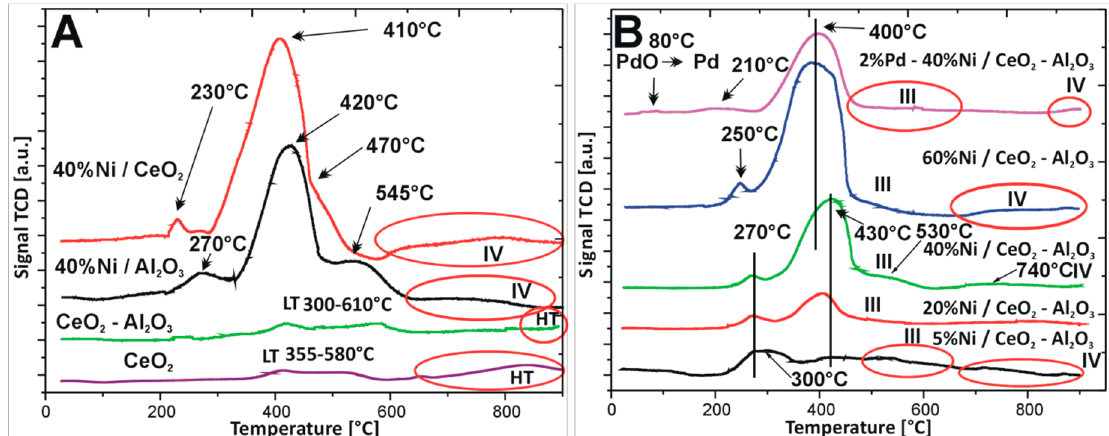
Figure 2. TPR profile of ( A ) supports CeO 2 , CeO 2 –Al 2 O 3 and monometallic catalysts supported on CeO 2 or Al 2 O 3 ; and ( B ) monometallic nickel catalysts supported on binary oxide and bimetallic systems after calcination in air atmosphere for 4 h at 400 °C.